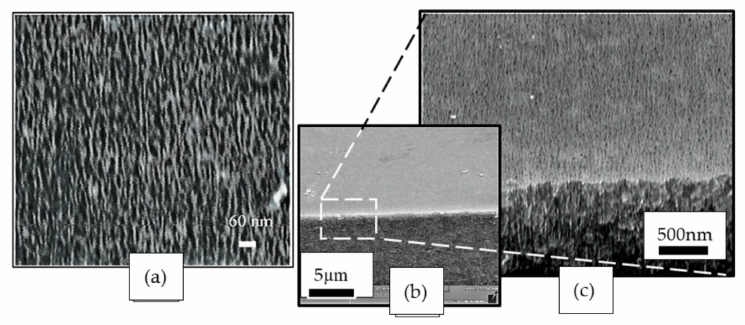
Figure 5. SEM image of the porous layer at the boundary of the porous layer with the outer sur-face of the silicon wafer: ( a ) surface image; ( b ) view of the angle of the chipping edge (5 µ m); ( c ) view of the angle of the chipping edge (500